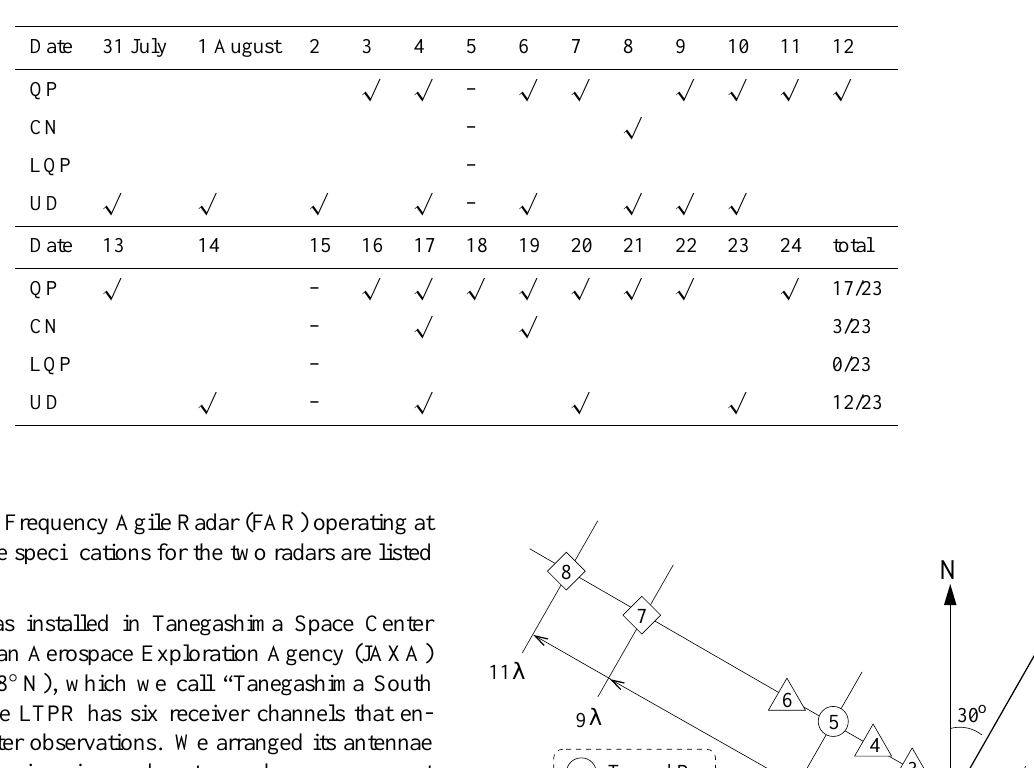
Table 2. Occurrence of FAI echoes for the LTPR. QP, CN, LQP, and UD stand for QP-type, Continuous-type, Low-altitude QP, and Undefined √ (structured but not quasi-periodic), respectively. “ ” means that the particular type of echoes were observed on the particular day. No data were available on 5 August and 15 due to system trouble.